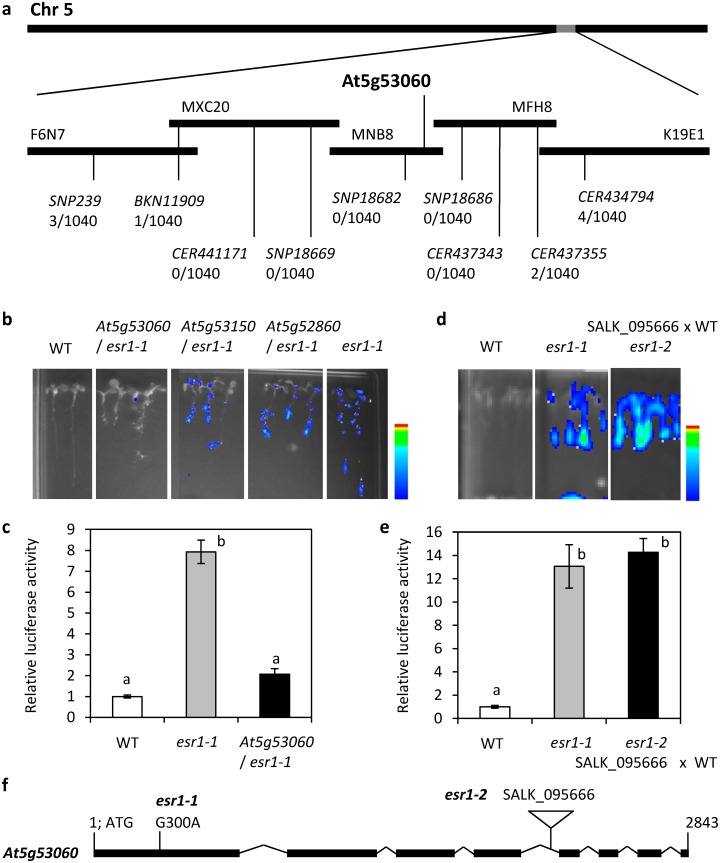
Molecular cloning of esr1-1.(a) Fine mapping of esr1-1 with recombination events from 1040 plants analysed for each marker shown. (b-c) Wild-type (WT) and esr1-1 genomes were sequenced and inspected for SNP differences within the mapped loci to identify 3 candidate genes. Molecular complementation of the esr1-1 mutation by the wild-type At5g53060 gene with (b) images and (c) luciferase quantification shown (P<0.05, all pairs Student’s t-test). (d-e) Genetic complementation between esr1-1 and a At5g53060 T-DNA knockout (SALK_095666) with (d) images and (e) luciferase quantification shown (P<0.05, all pairs Student’s t-test). The esr1-2 mutant is an F3 line from a cross between WT plants and the T-DNA insertion line SALK_09566 and is homozygous for the T-DNA insertion and GSTF8:LUC transgene. (f) Structure of the At5g53060 gene with esr1-1 mutation and T-DNA knockout locations indicated. Filled boxes indicate exons, joining lines indicate introns. Positions are relative to the start codon.